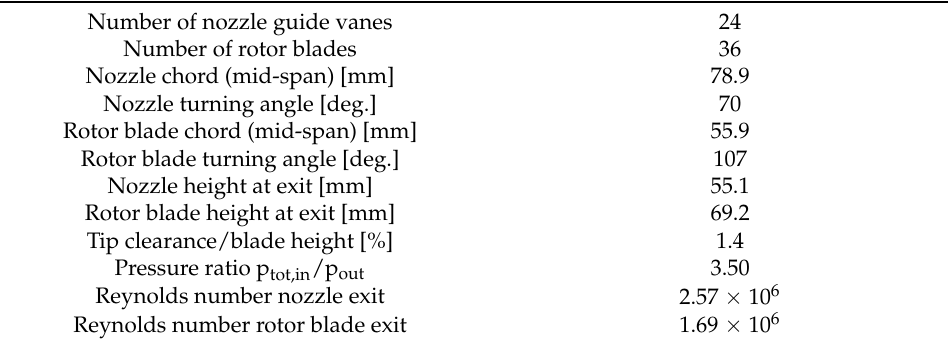
Figure 1. Meridional view of flow channel ( left ) and blade contours with measurement planes ( right ). Table 1. Stage geometrical data and operating conditions.